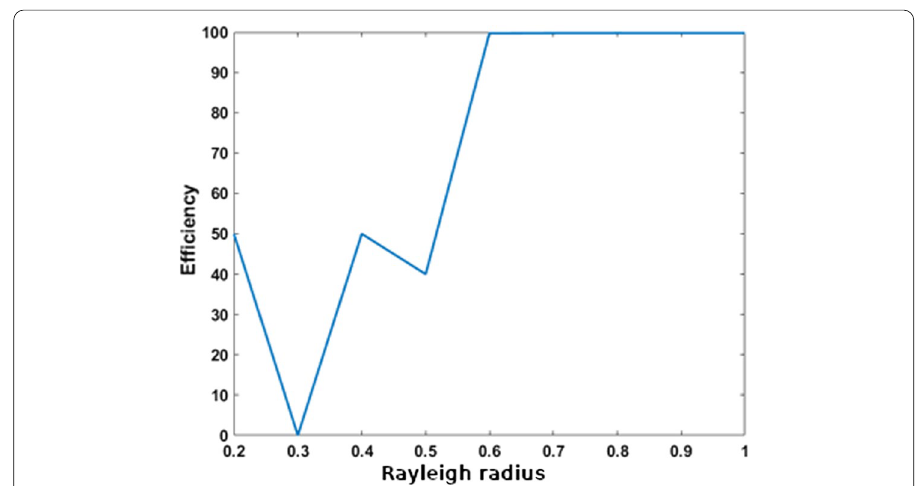
Fig. 7 Efficiency of the sheaf algorithm as a function of separation between two stars when the star count is unknown